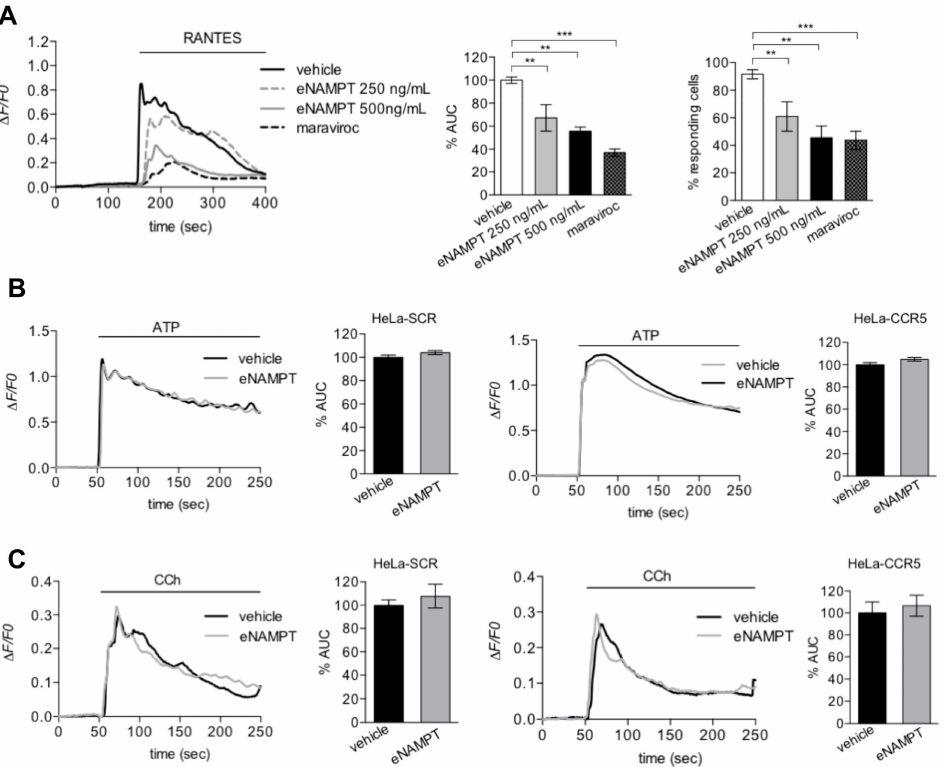
Figure 4. eNAMPT inhibits Rantes-induced cytosolic Ca2 + -signals. ( A ) Representative calcium traces of HeLa-CCR5 loaded with FURA-2AM and treated with vehicle, eNAMPT (250 ng / mL; 4.5 nM or 500 ng / mL = 9 nM), or maraviroc (10 µ M) 100 s before the addition of 25 ng / mL (3 nM) of Rantes. Histograms of responding cells (middle panel) and percentage of Area Under the Curve ( AUC )(right panel) as mean ± S.E.M. (248–410 cells from 6–11 independent experiments). ( B , C ) Representative calcium traces and percentage of AUC of HeLa-SCR and HeLa-CCR5 loaded with FURA-2AM and treatedwith3 µ MofATP( B )or300 µ MofCCh( C )aloneorpretreatedwitheNAMPT(500 ng / mL = 9 nM) for 5 min. The data are summarized in histograms and expressed as mean ± S.E.M of 120–190 cells (from 5–9 independent experiments) and 105–185 cells (from 5–9 independent experiments), respectively. ** p < 0.01 *** p <